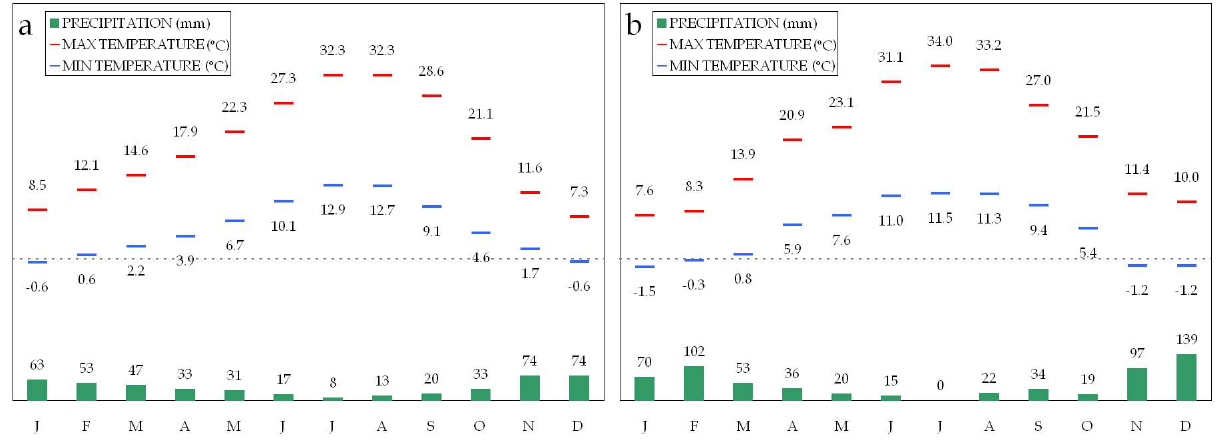
Fig. 2. (a) The climate chart for Medford, Oregon, the USA, and (b) the monthly averaged data for the minimum and the maximum temper- atures and the precipitation of the simulated